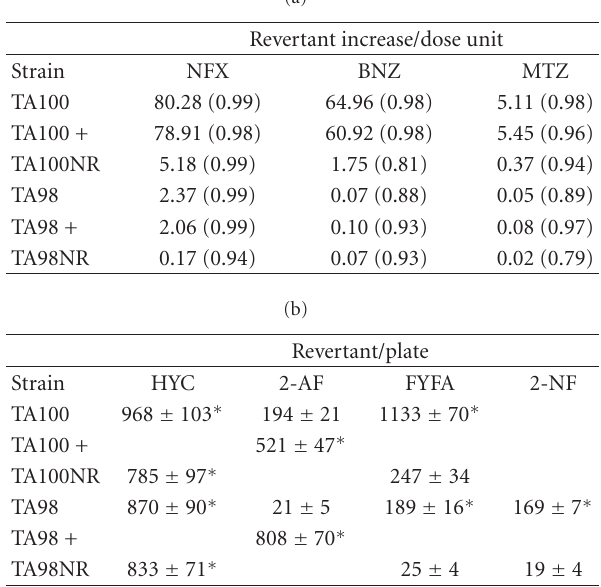
Table 1: Specific mutagenic activity (revertant increase/dose unit calculated by linear regression analysis on the curve section with response linearity) of NFX, BNZ, and MTZ on di ff erent Salmonella strains without or with (+) S9 mix; in brackets: r 2 value (A). Positive controls are reported for each strain (HYC: hycantone; 2-AF: 2- aminofluorene; FYFA: furylfuramide; 2NF: 2-nitrofluorene); mean ( ± SD) of three plates (B). ∗ P < . 05 Dunnett’s